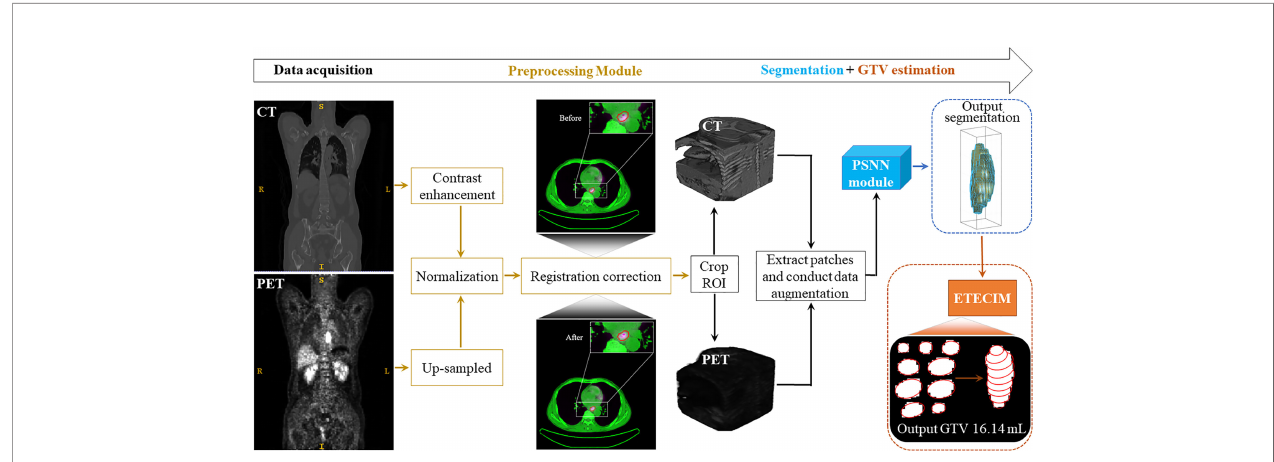
FIGURE 3 | Overview. The wholeGTV de fi nition process for ESCC patient includes four stages: dataacquisition,data preprocessing, segmentation,and GTV